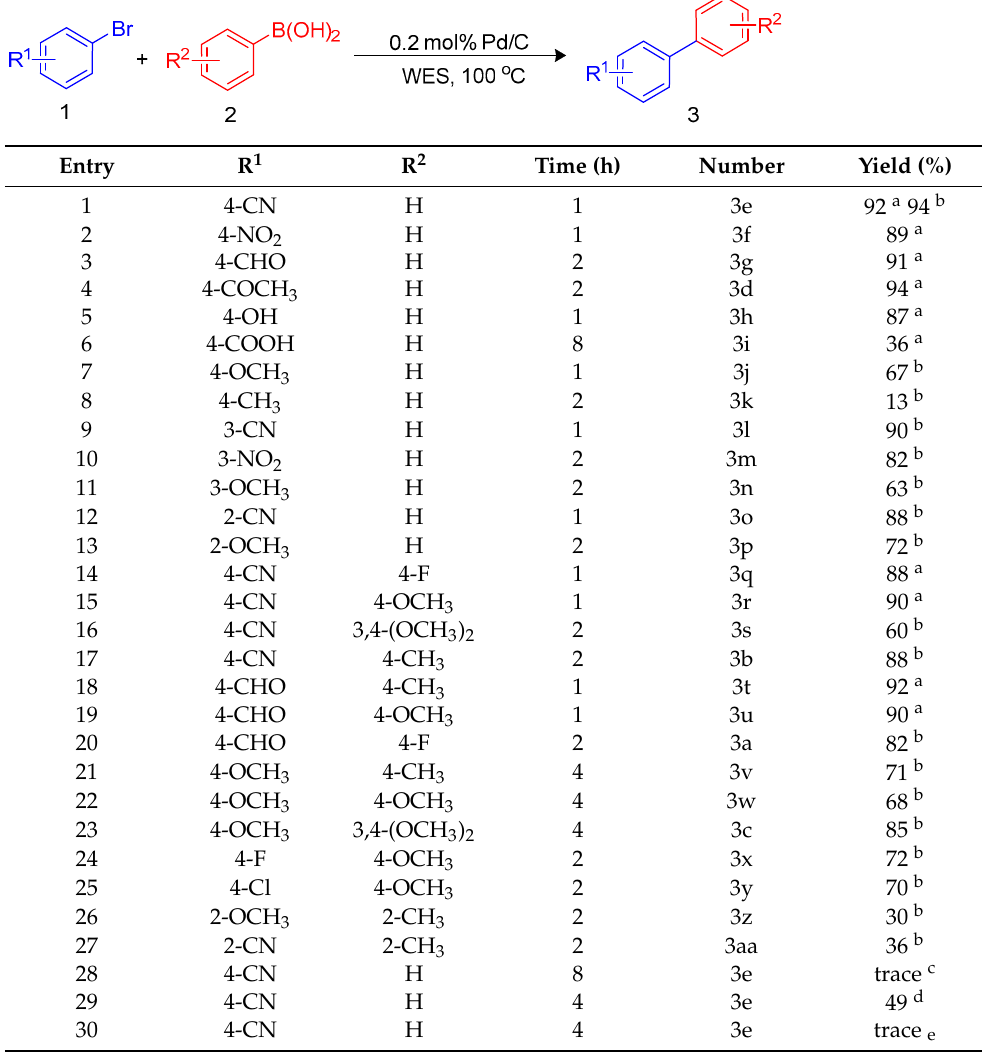
Table 2. The Suzuki–Miyaura reaction in aqueous extract of suaeda salsa a.